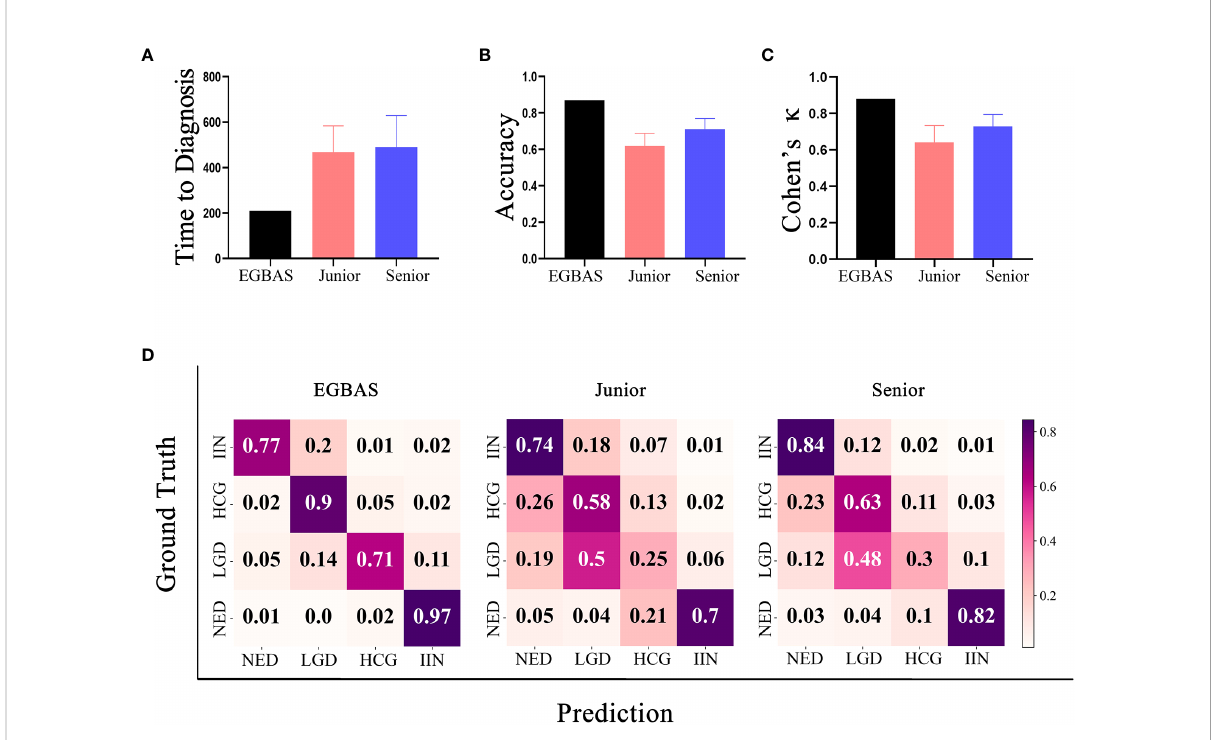
FIGURE 4 Results of the comparison between the endoscopic gastric biopsy assistant system (EGBAS) and pathologists using the man-machine comparison test dataset. (A) The length of time for the EGBAS and pathologists (junior and senior) to complete the dataset. (B) The overall accuracy of the EGBAS and pathologists (junior and senior). (C) The mean k value of the EGBAS and pathologists (junior and senior). (D) A confusion matrix of the EGBAS, junior pathologists, and senior pathologists using the man-machine comparison test